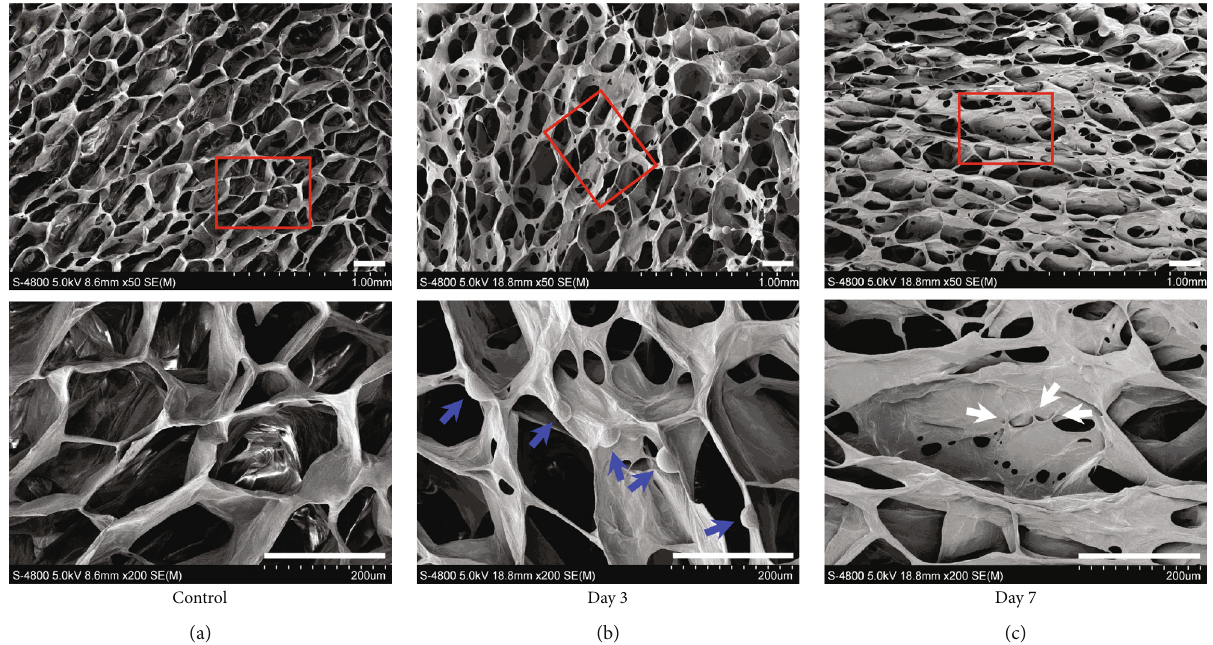
Figure 4: The ultrastructural feature of VitroGel 3D-RGD and its e ff ect on the growth of DPSCs. (a) The surface ultrastructure of the hydrogel was detected via scanning electron microscopy (SEM). (b) and (c) SEM imaging of DPSCs cultured in the hydrogel system at day 3 and 7, respectively. Red boxed areas in the fi rst row were zoomed in and displayed in the second one. The cells attached near the pore wall were pointed out with blue arrows. White arrows indicate cellular pseudopodia. The images were captured from three independent tests ( n =3). Scale bar =200 μ